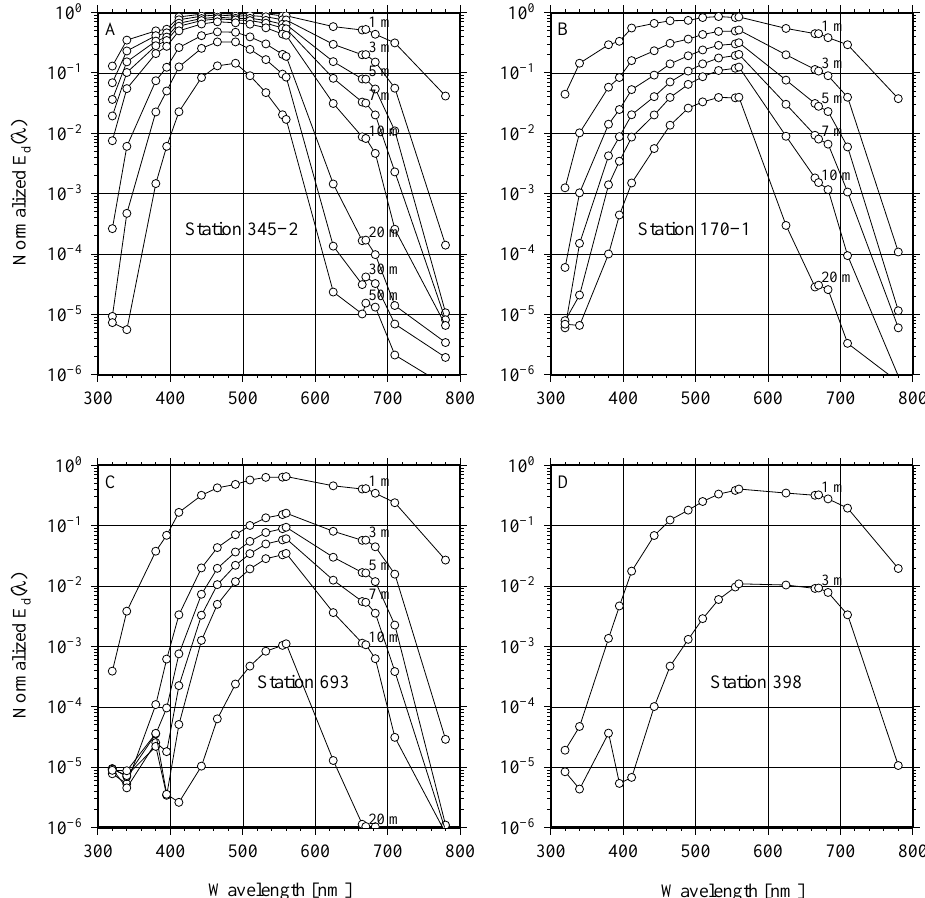
Fig. 3. Example spectra of the downward irradiance at various depths and four stations as indicated. Values are normalized to the maximum E d found just below the sea